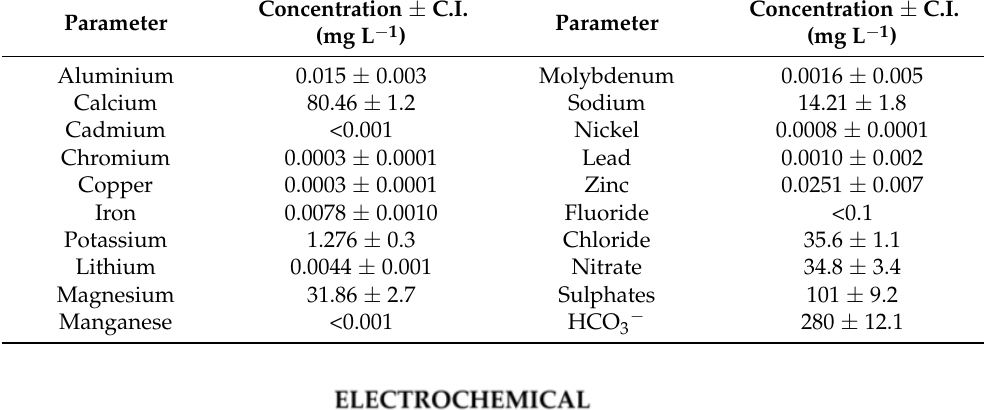
solutions (n = 3). C.I.: confidence interval.